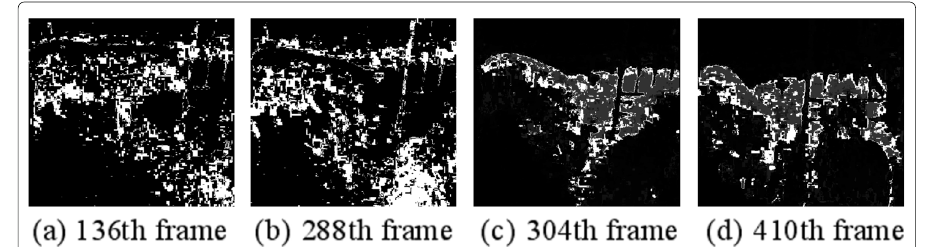
Fig. 3 Projection diagram of basic Camshift probability